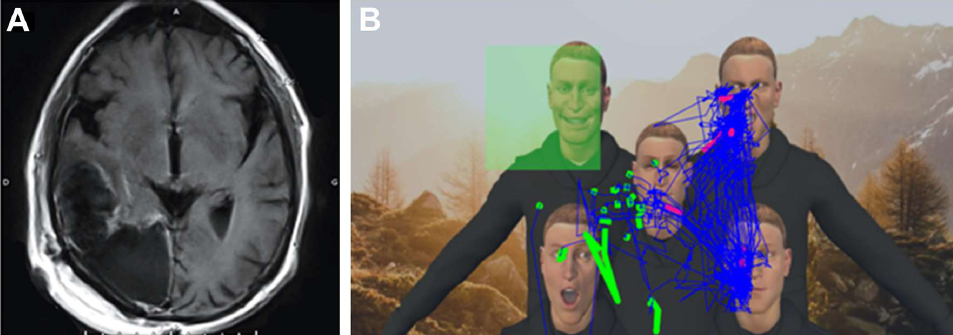
Figure 3. ( A ) Postoperative MRI scan for a patient with malignant right occipital glioma. The patient presented with homonymous hemianopia and USN. ( B ) Postoperative bedside VR-TANGO test: eye-tracking feedback for 10 cumulative tests. The patient was asked to determine the emotion expressed by the face looking at him (here, the upper left face, indicated by the green square). The eye tracking data recorded for the patient (blue lines) showed that he was unable to direct his attention to the left side. (USN, unilateral spatial neglect). During AC, several defects induced by subcortical DES with the VR-TANGO task were observed. For example, DES of the superior longitudinal fasciculus (SLF) induced mild USN, with the patient having difficulty exploring the left part of the VR screen (Fig- ure 4B,C,D). Without DES, the patient was able to explore the entire VR screen in gaze tient easily identified the correct avatar, but was unable to analyze or describe the facial emotion expressed (data not shown). This is not surprising, because the ILF and other ventral tracts have already been implicated in the recognition of facial emotions [43].